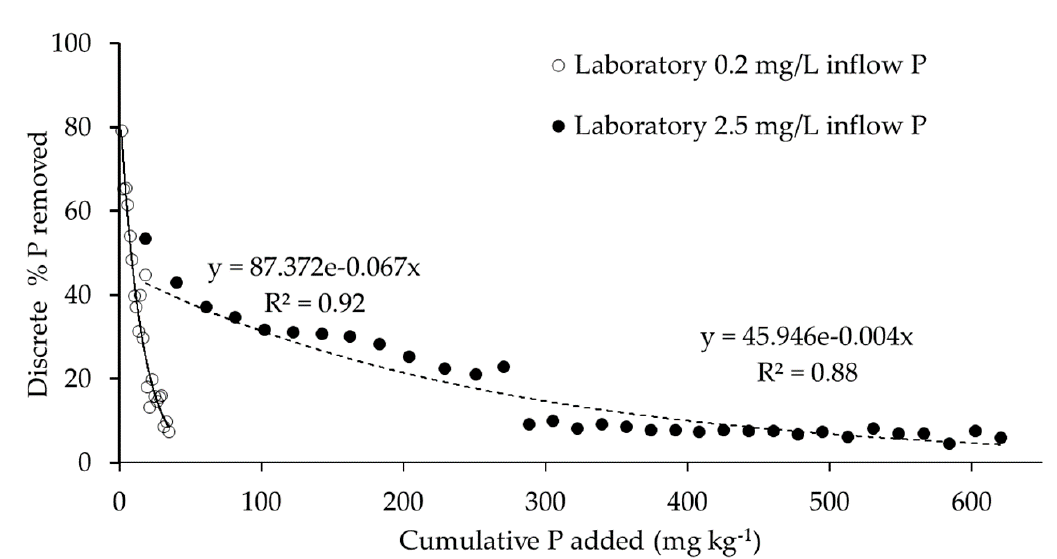
Figure 2. Discrete dissolved phosphorus (P) removed by the slag under laboratory flow-through conditions with a retention time of 10 min and inflow concentrations of 0.2 and 2.5 mg L − 1 , expressed as a function of cumulative P added per kg slag. Both relationships were significant at p < 0.05.